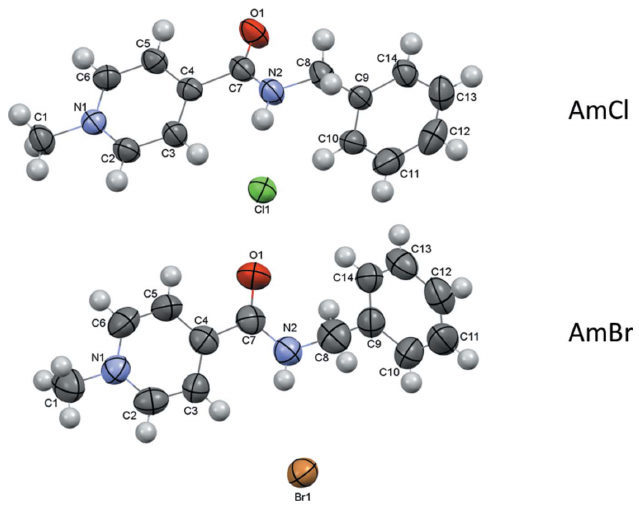
Figure 1 Molecular structures of the title 4-[(benzylamino)carbonyl]-1-methyl- pyridinium halogenide salts. Displacement ellipsoids are shown with 50% probability level.